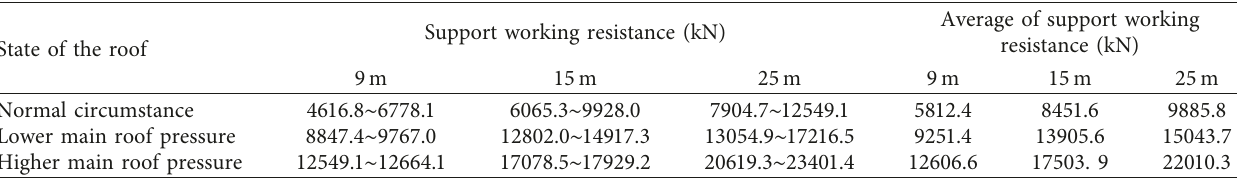
Table 7: Support working resistance under different conditions of basic roof movement in different thick coal